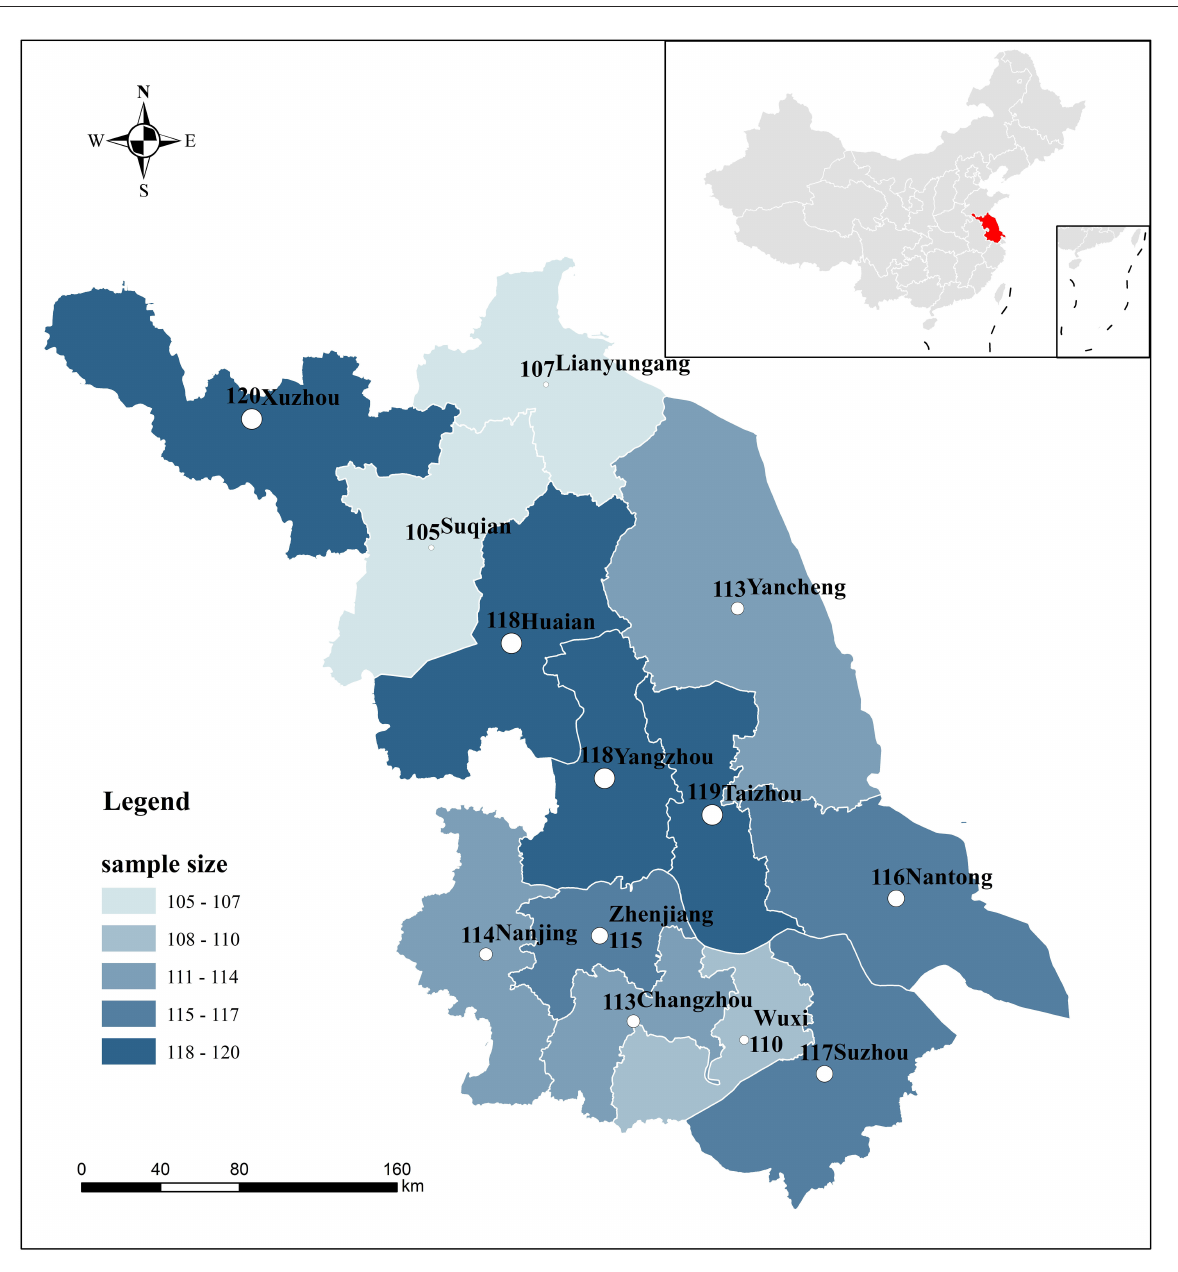
FIGURE1 Map of the study setting (Jiangsu province and its 13 prefecture-level cities) and distribution of survey responses. The figure accompanying the name of a city represents the exact number of study participants from that city.